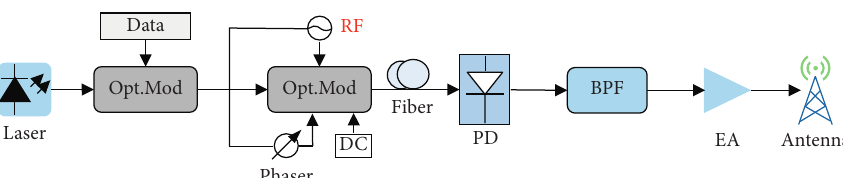
Figure 3: Multiple modulators cascade in external modulation scheme structure diagram.